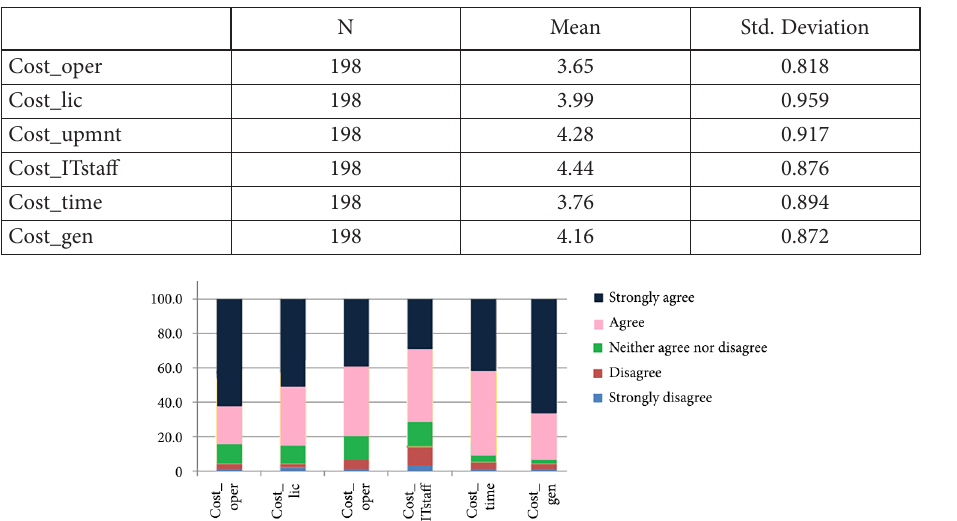
Figure 9. Respondents’ viewpoints regarding the variable managers’ ideas on the costs Table 9 integrates the descriptive analysis of items which are associated with security